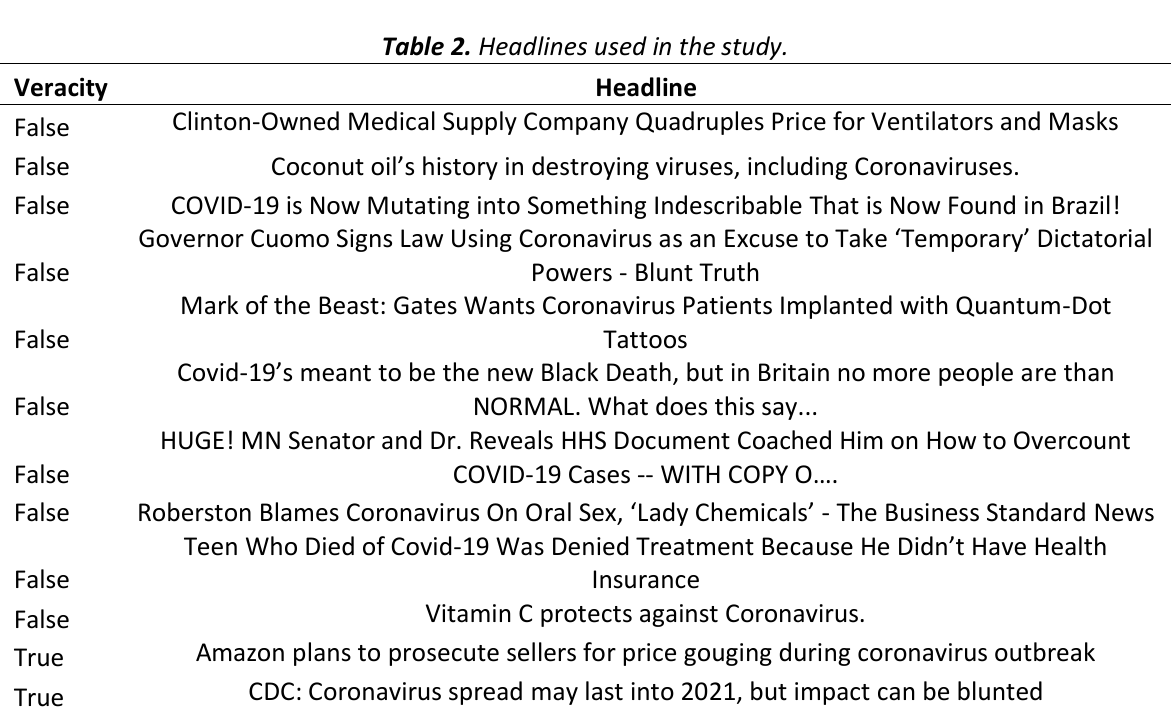
Table 2. Headlines used in the